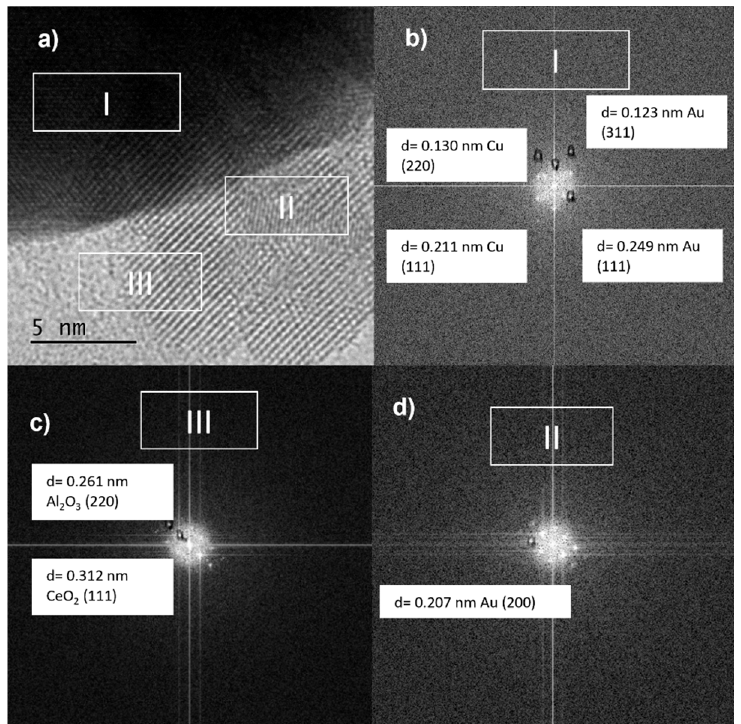
Figure 12. ( a ) TEM image and ( b , c , d ) Lattice spacing of arbitrarily selected bimetallic nanoparticles of bimetallic AuCuAlCe catalyst.